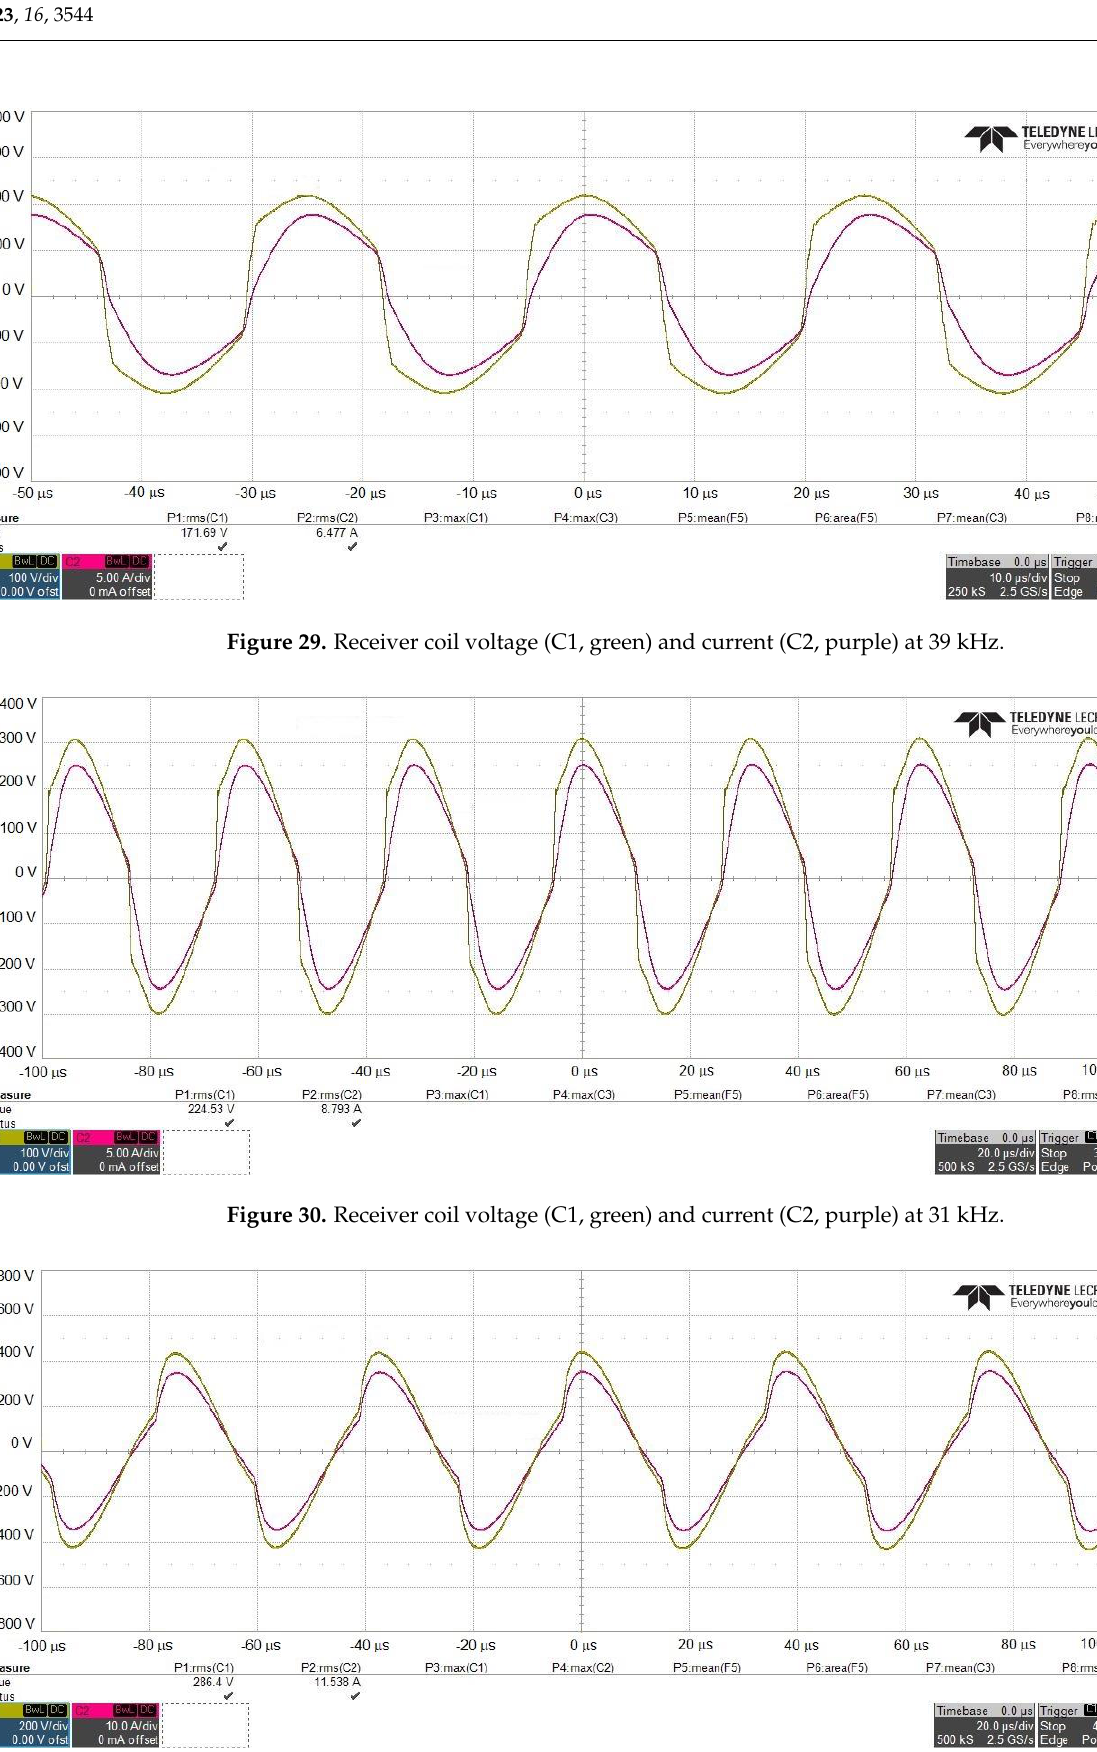
Figure 31. Receiver coil voltage (C1, green) and current (C2, purple) at 26.